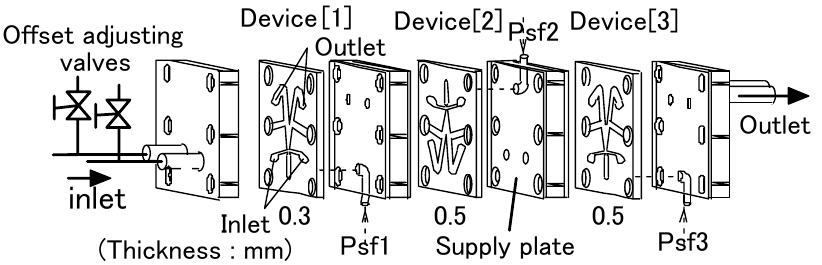
Fig. 5 Construction of fluidic amplifier using tested fluidic